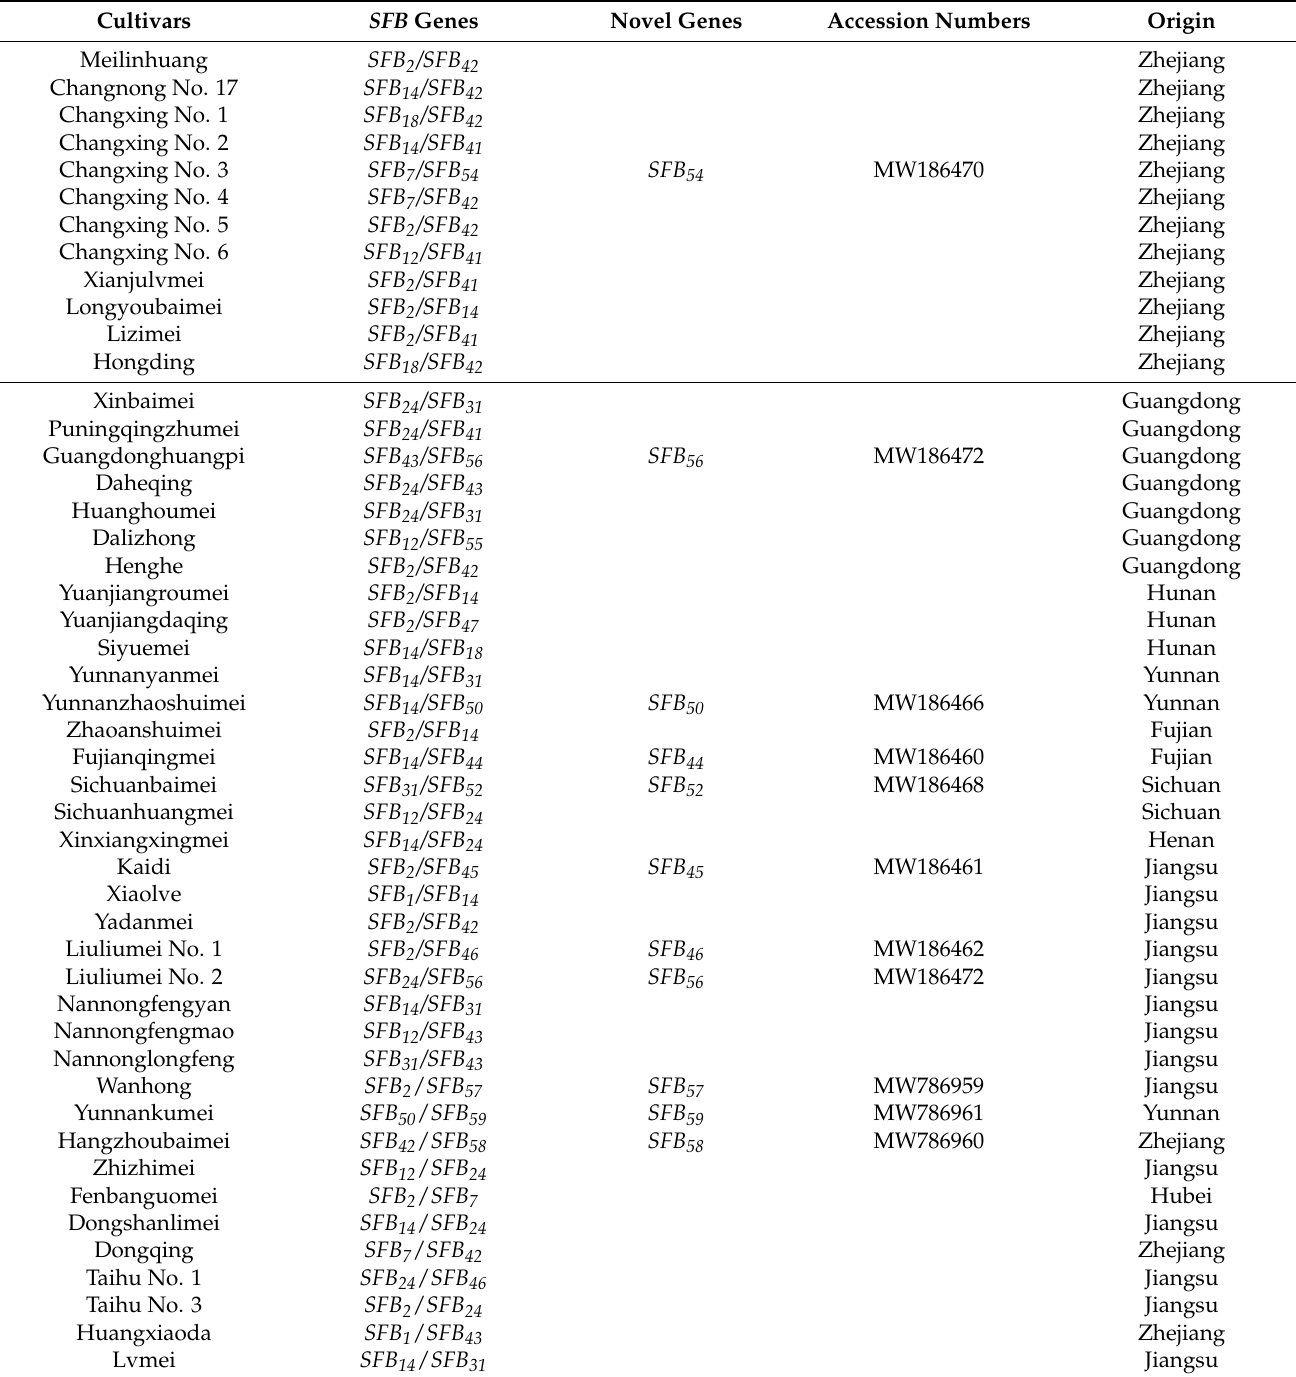
Table 1. SFB genotypes of 48 P. mume